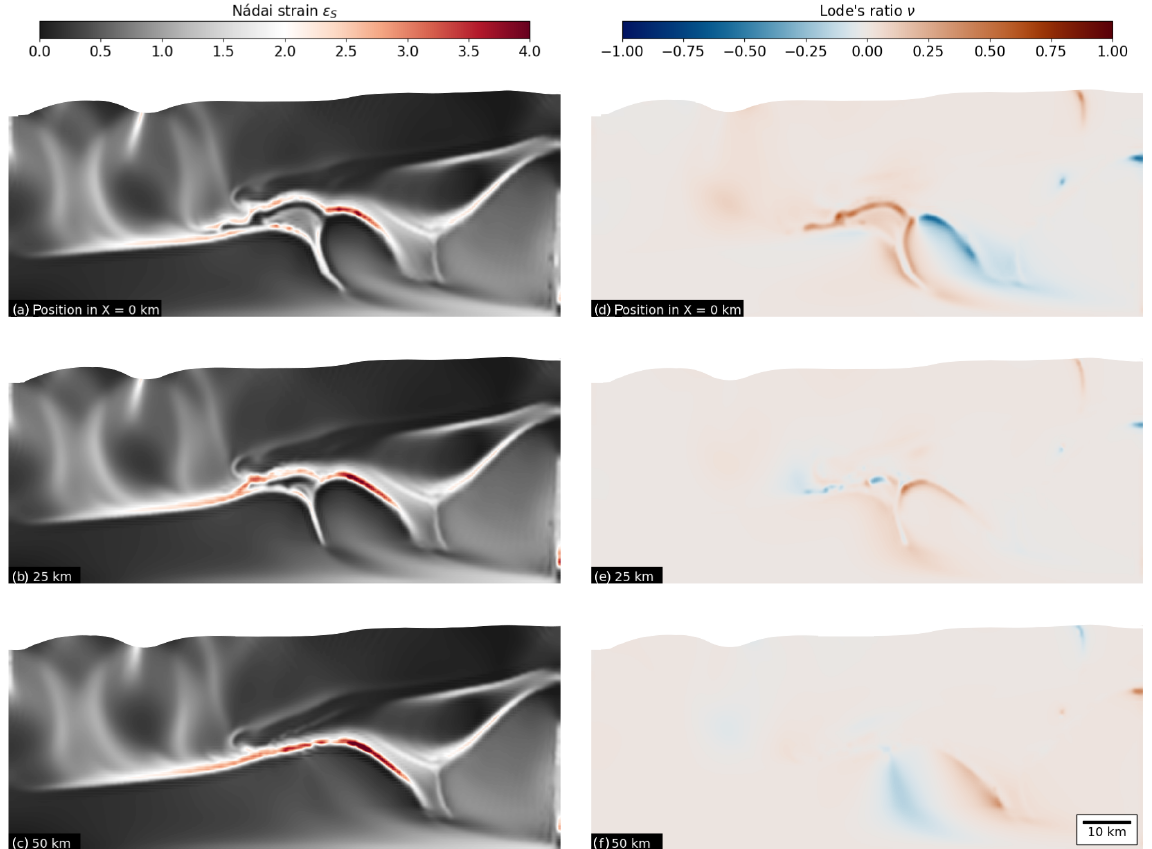
Figure 12. Graph showing three different cross sections of model A.G-1, displaying Nádai strain (a–c) and Lode’s ratio (d–f) (colour map from Crameri, 2019). Row-wise cross sections at X = 0, 25 and 50km,